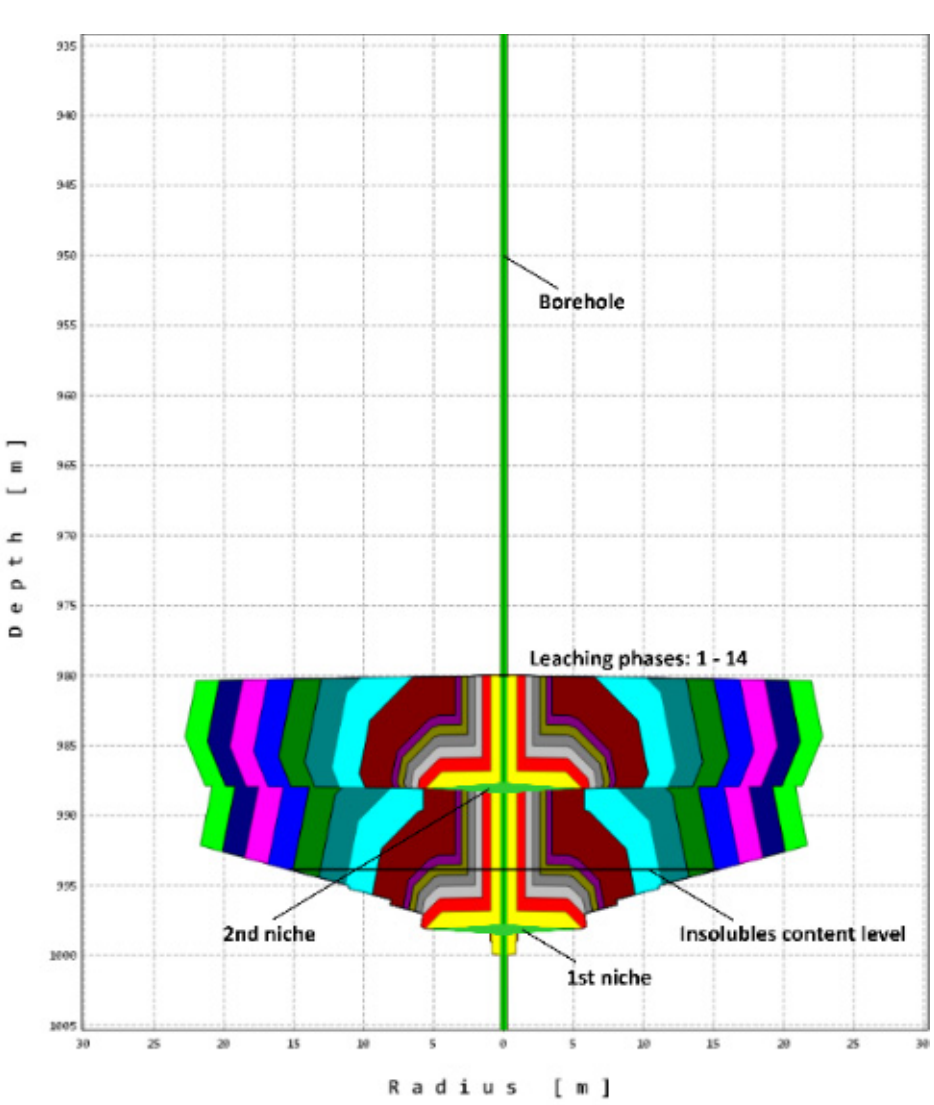
Figure 6. Sump shape after the end of leaching for scenario 2—2 niches (S I/S 2—2 niche).